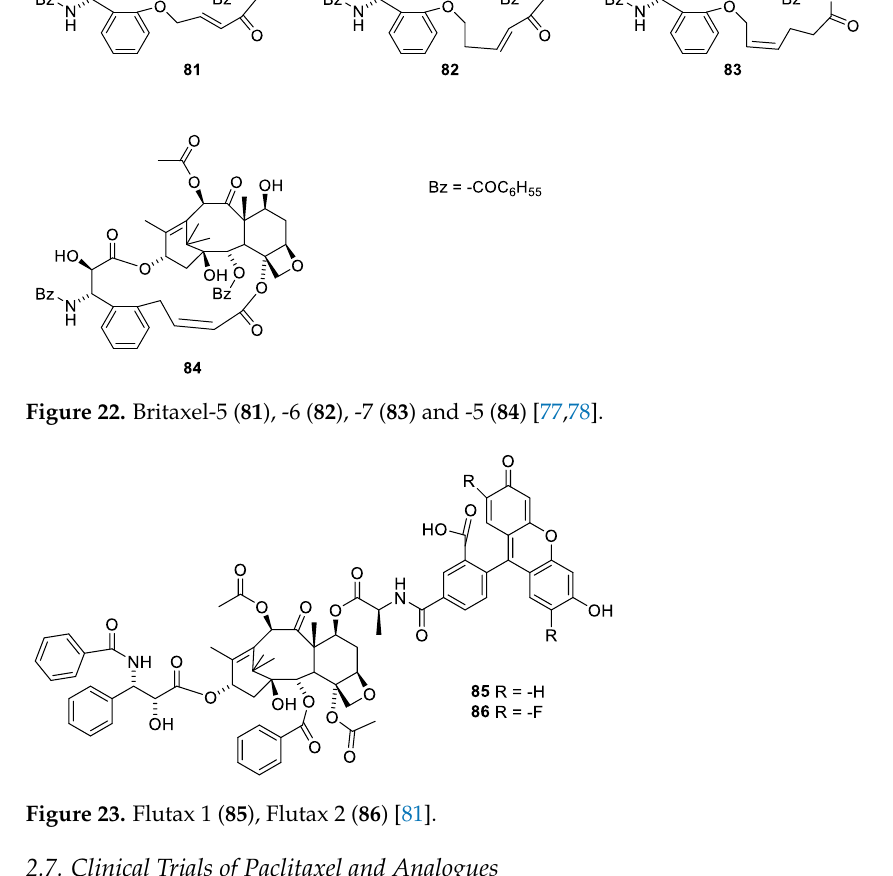
Molecules 2022 , 27 , x FOR PEER REVIEW 23 of 32